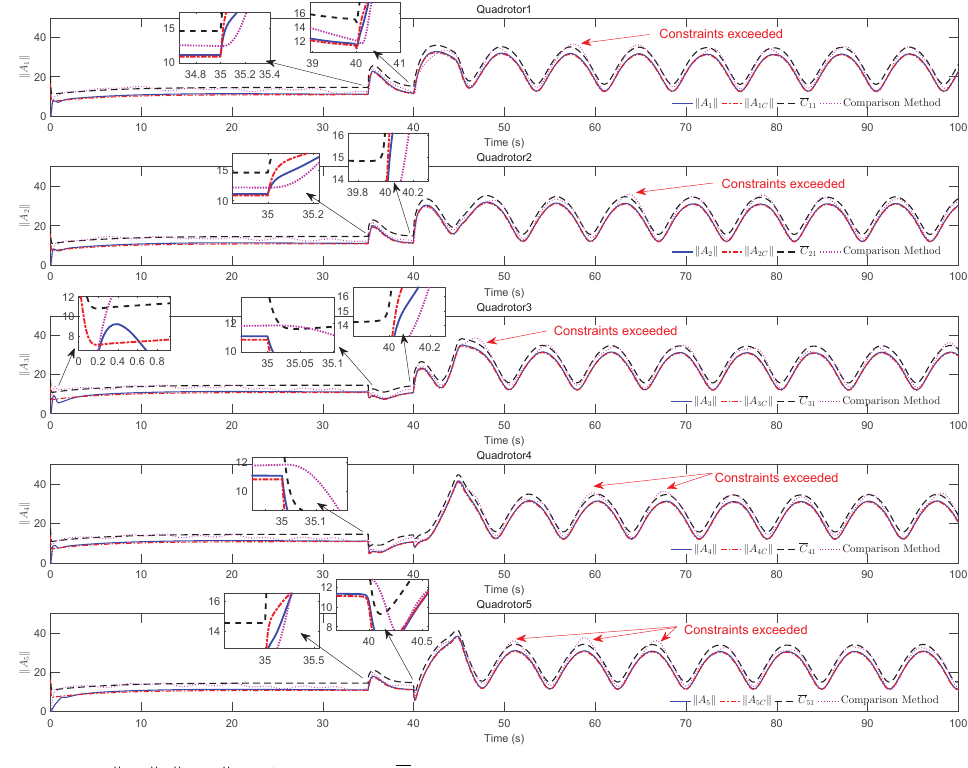
Figure 9. (cid:107) A i (cid:107) , (cid:107) A iC (cid:107) and constraints C i 1 , i = 1,2,3,4,5.